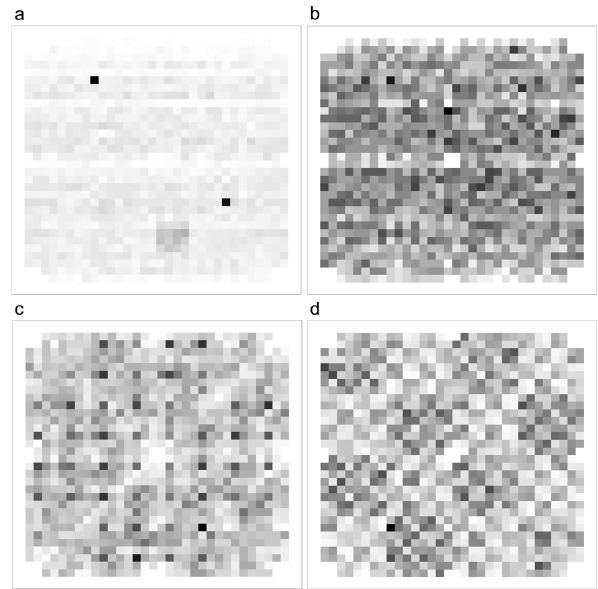
Fig.4|Sequencefragmentdistributions. mCGRrepresentingthefrequencyofall possible sequences of length 5 for Hedges ( a ), DNA-Aeon ( b ), Grass code ( c ) and DNA Fountain ( d ). Source data are provided as a Source Data fi le.